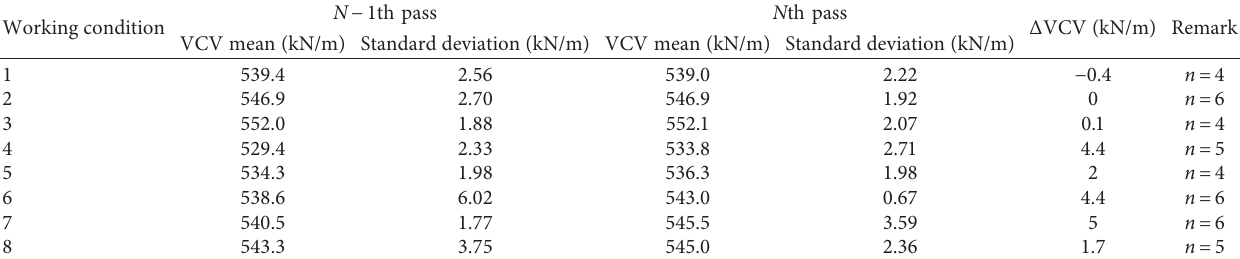
Table 5: Analysis of the results of continuous compaction of VCV values at the K8 station. Working condition